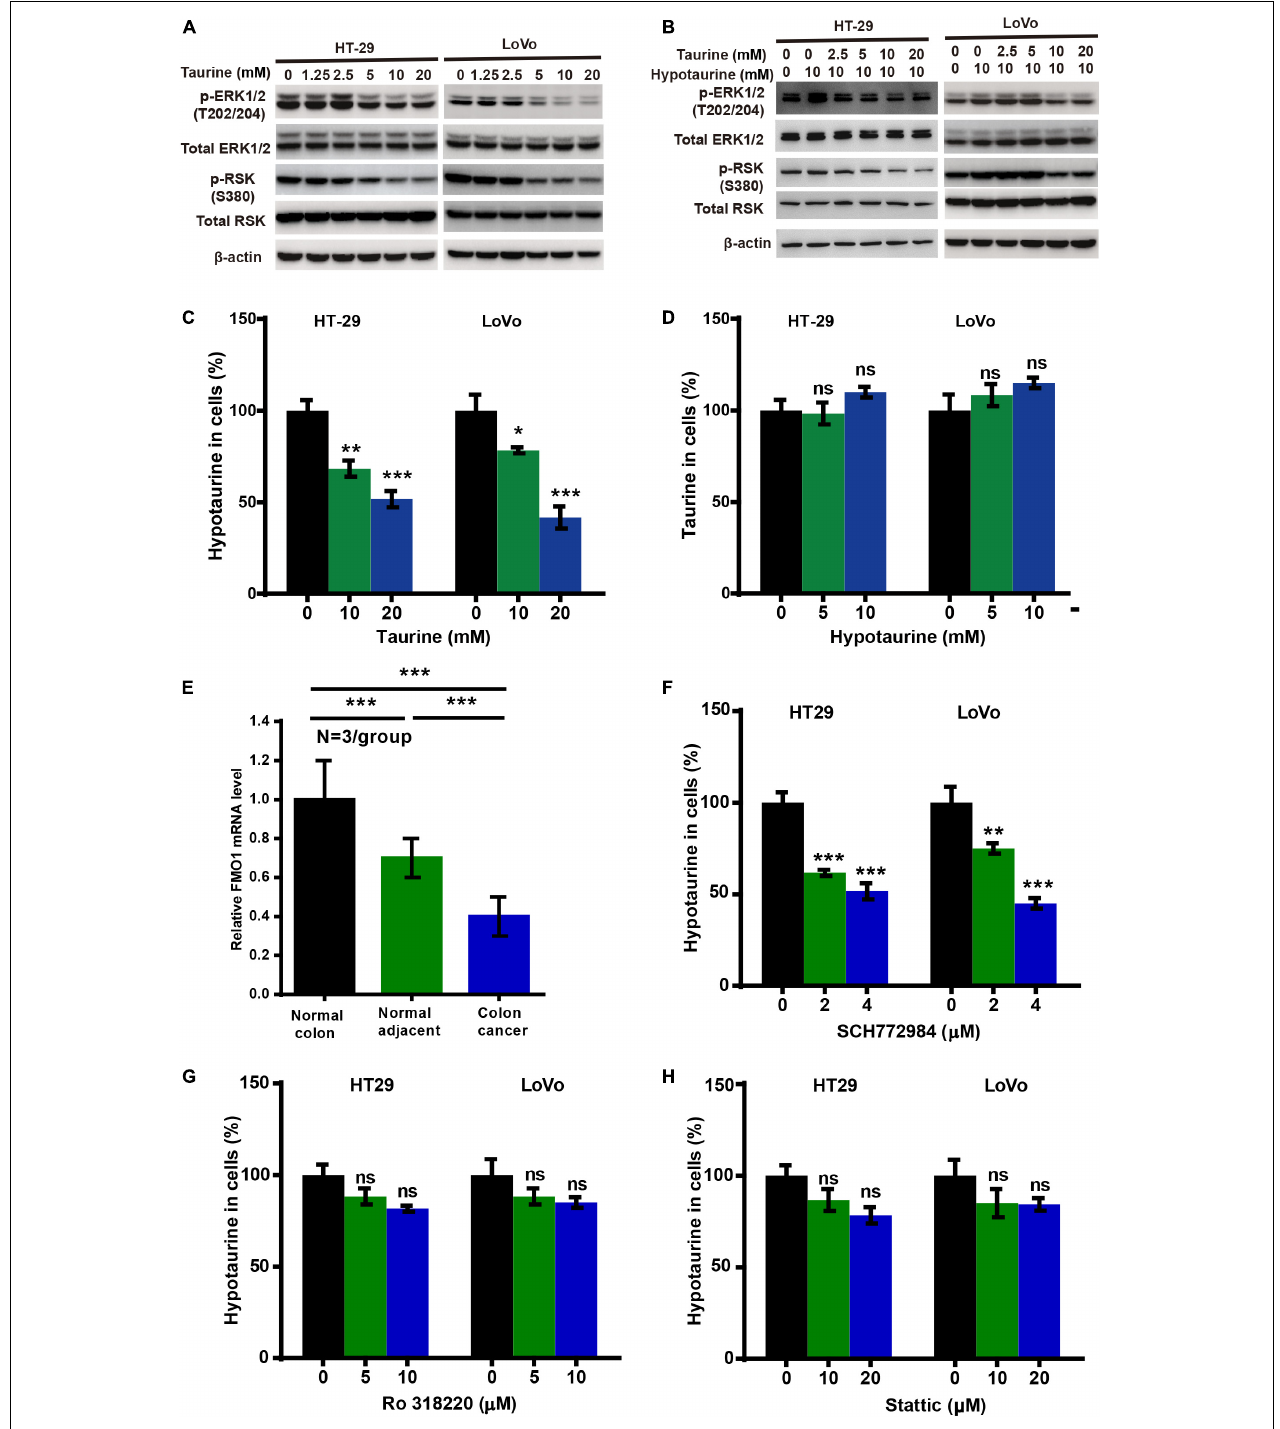
FIGURE 5 | Taurine reverses the promoting effects of hypotaurine on tumor progression and EMT through the ERK/RSK pathway, and decreases intracellular hypotaurine levels in CRC cells. (A,B) The effects of taurine and/or hypotaurine on the phosphorylation (denoted p-) status of ERK and RSK were assessed with western blotting analysis. (C,D) CRC cells were incubated for 24 h in medium with the indicated concentrations of taurine or hypotaurine, and intracellular hypotaurine or taurine concentrations were identified by LC-MS analysis (means ± SEM) (one-way ANOVA followed by Tukey’s post hoc test, * P < 0.05, ** P < 0.01, *** P < 0.001). (E) FMO1 mRNA expression in normal colon, normal colonic tissues adjacent to cancer, and colon cancer were determined by qRT-PCR (means ± SEM) ( N = 3/group; one-way ANOVA followed by Tukey’s post- hoc test, *** P < 0.001). (F–H) CRC cells were incubated for 24 h in medium with the indicated concentrations of different ERK inhibitors (SCH772984, Ro 318220, and Stattic), and intracellular hypotaurine concentrations were identified by LC-MS analysis (means ± SEM) (one-way ANOVA followed by Tukey’s post hoc test, ** P < 0.01, *** P < 0.001).